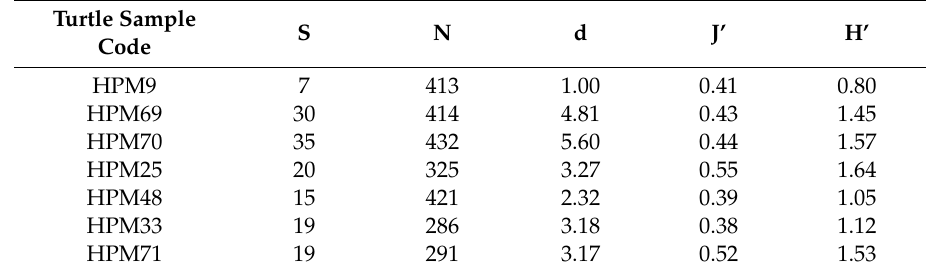
Table 2. Number of diatom taxa found (S), number of valves counted (N), and values of the Margalef’s species-richness (d), Pielou’s evenness (J’), and Shannon–Wiener diversity (H’) indices calculated for each turtle